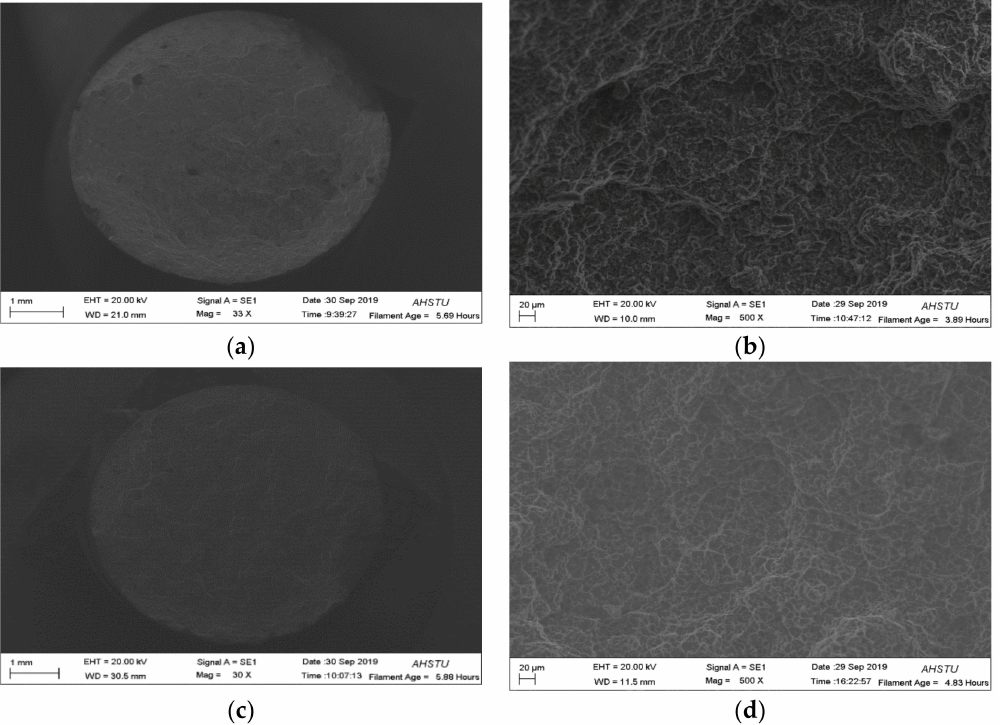
Figure 9. Impact fracture morphologies of the non-heat-treated die-cast aluminum alloy samples: ( a ) fracture surface before heat treating, ( b ) high magnification fracture surface before heat treating, ( c ) fracture surface after heat treating, ( d ) high magnification fracture surface after heat